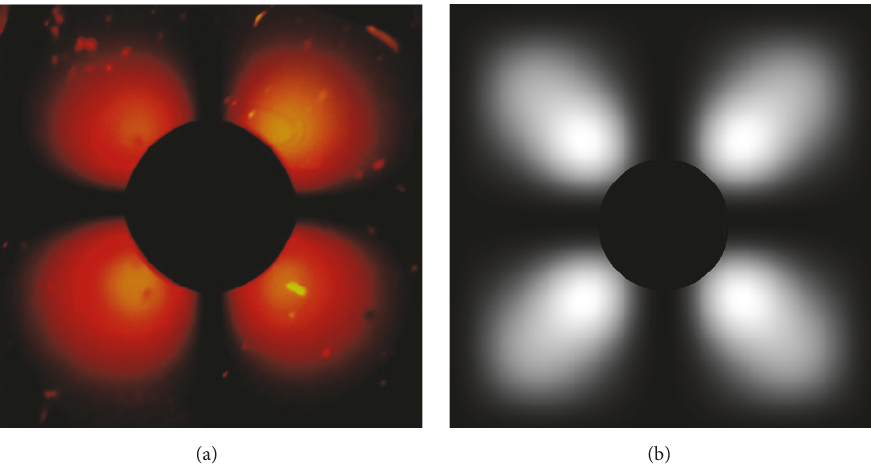
Figure 4: (a) The pattern of light polarization from the Ferrocell with a cylindrical magnet placed in the monopolar configuration. The simulation of this configuration is presented in